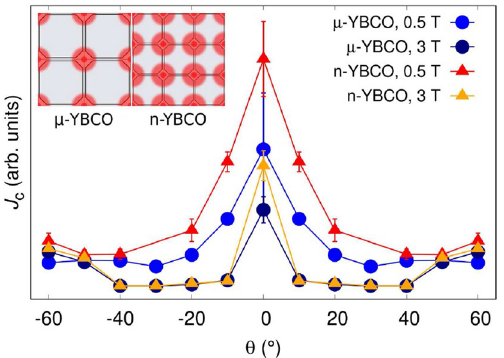
Figure 9. Simulated J c (θ) datapoints for µ -YBCO and n-YBCO in two magnetic fields of 0.5 and 3 T. J c values are given in arbitrary units but the absolute levels of the curves are comparable with each other. The inset shows the schematic networks of growth islands with different diameters in µ -YBCO and n-YBCO films, which produce different densities of threading dislocations along the YBCO c -axis. In the simulations, the only difference between the samples is the number of threading dislocations (the diameter of 1 nm), three times more in n-YBCO than in µ